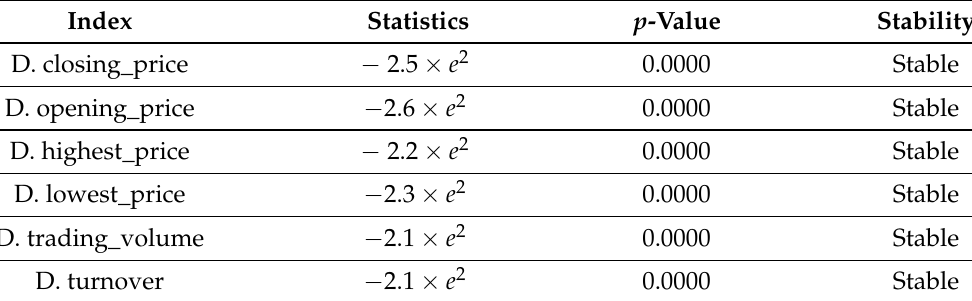
Table 3. Results of LLC panel unit root test for first-order differences of